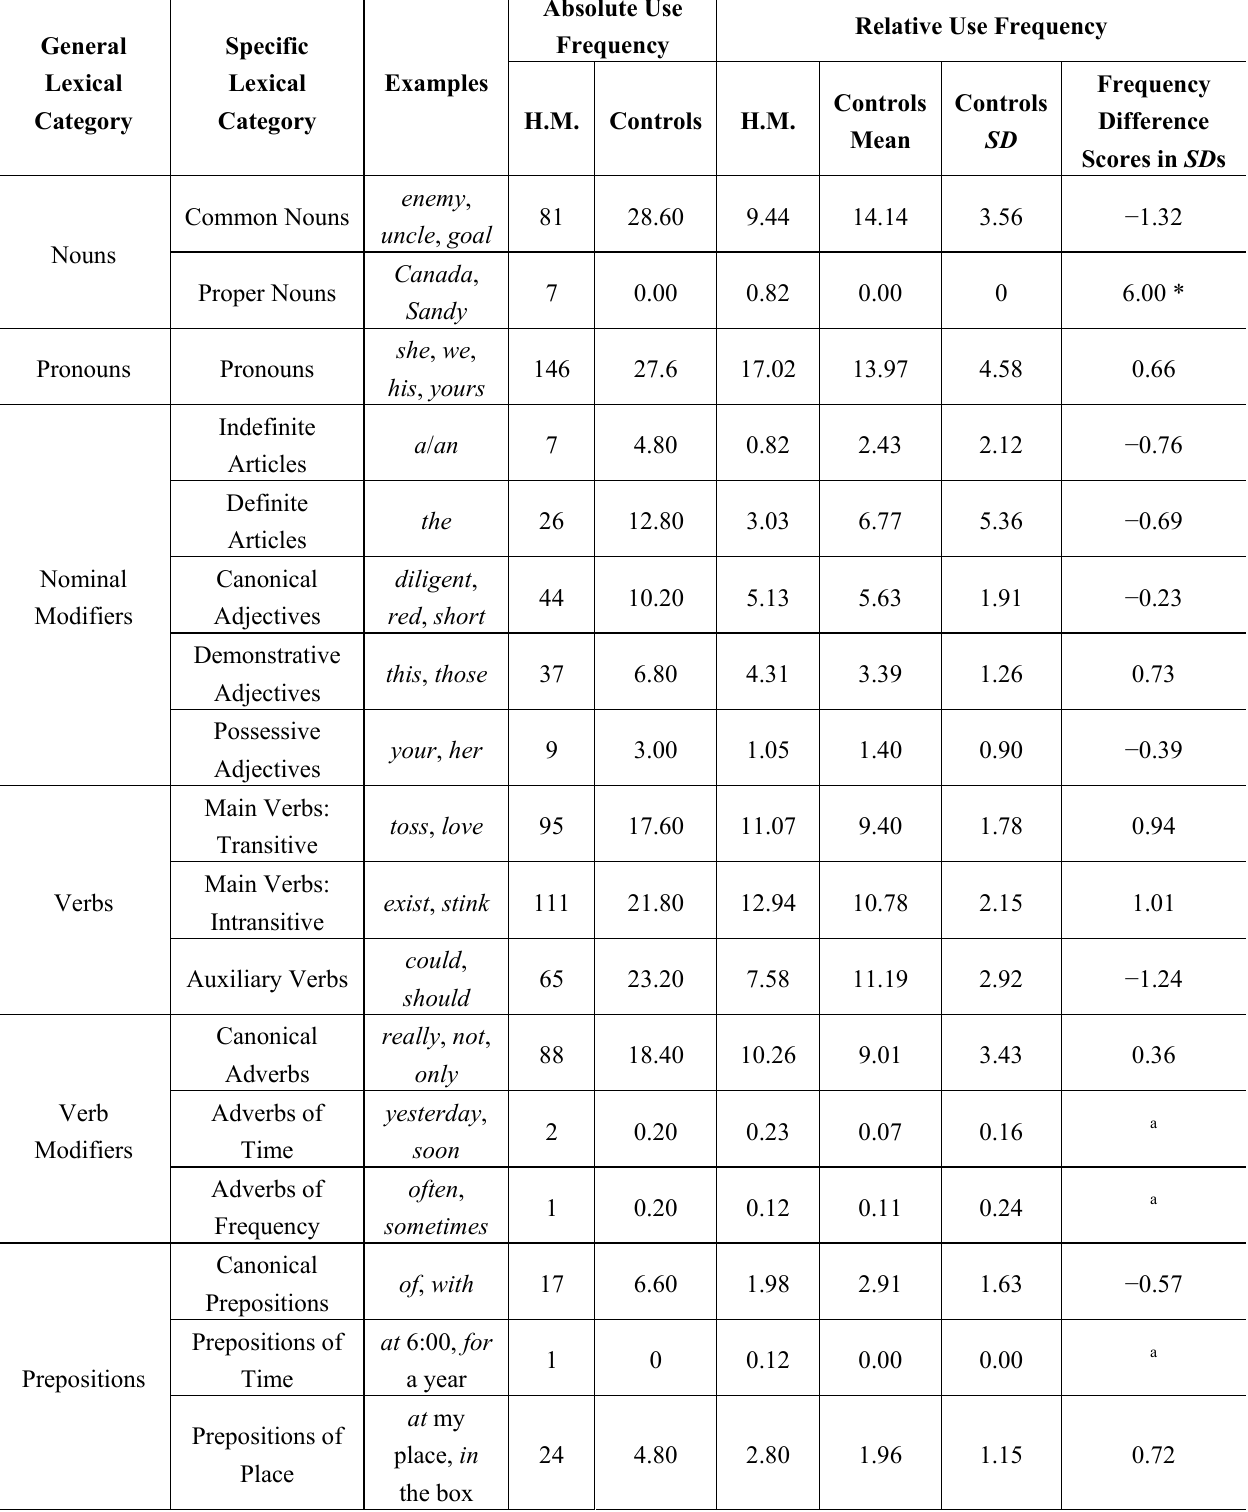
Table 3. Absolute and relative use frequency of Study 1 lexical categories, excluding target words.